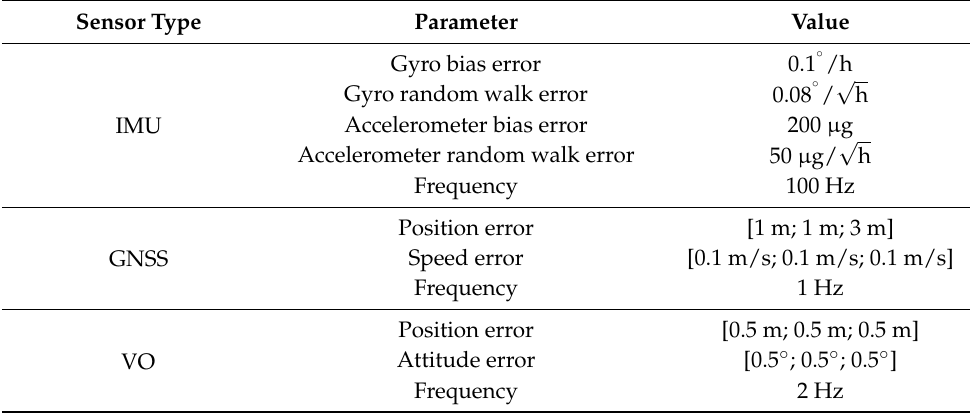
Table 1. Sensor parameter